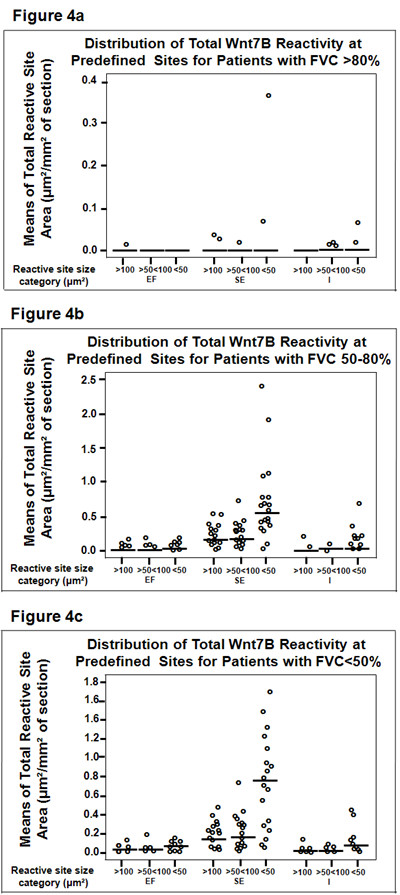
Distribution of the total Wnt7B reactivity at the EF, SE, and I site categories for patients with FVCs >80% (normal), 50-80% (intermediate impairment), or <50% (severe impairment). Normal patients had minimal Wnt7B reactivity, most with a median total area reactivity of “0” (a). Patients with impaired FVCs had many more reactive sites than controls, although those with intermediate and severe impairment were not different (see Tables 2 and 3). Notably, the median of the mean total of reactivity was greatest in the SE sites that were <50 μm² (b-c).